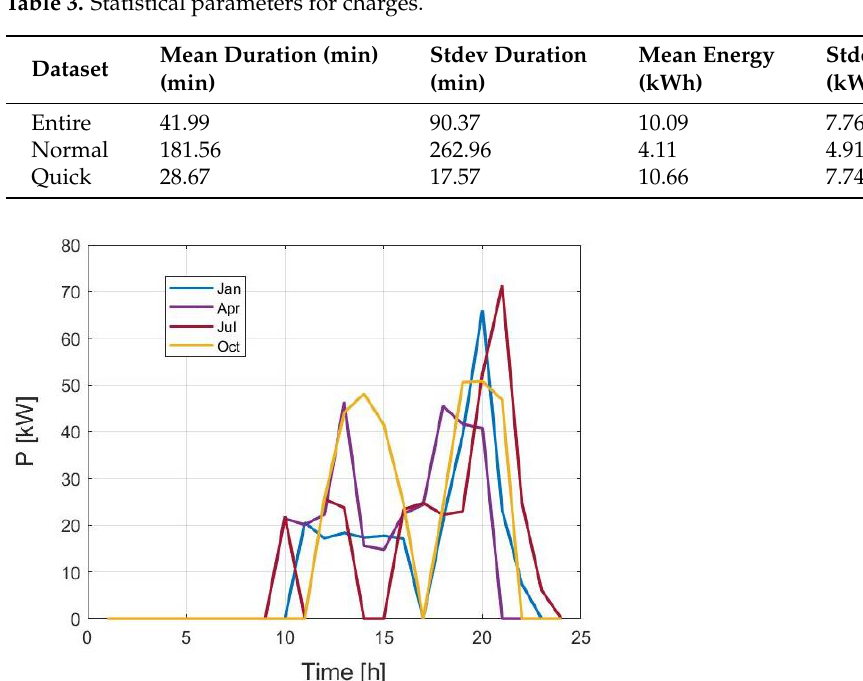
Table 3. Statistical parameters for charges.